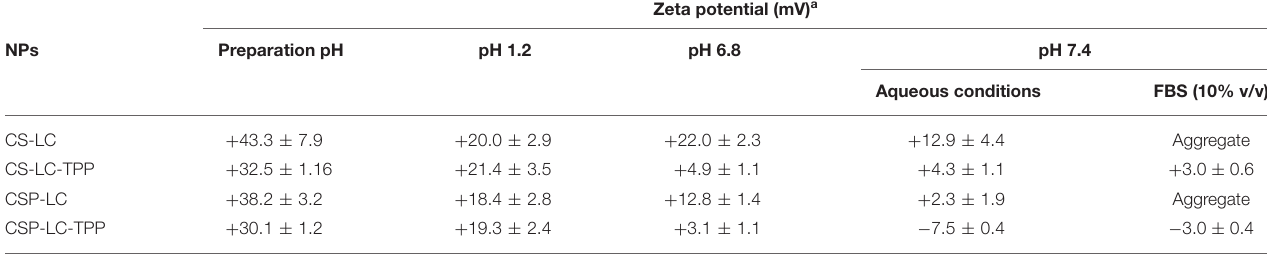
TABLE 3 | Unloaded-NPs zeta potentials at varying pH